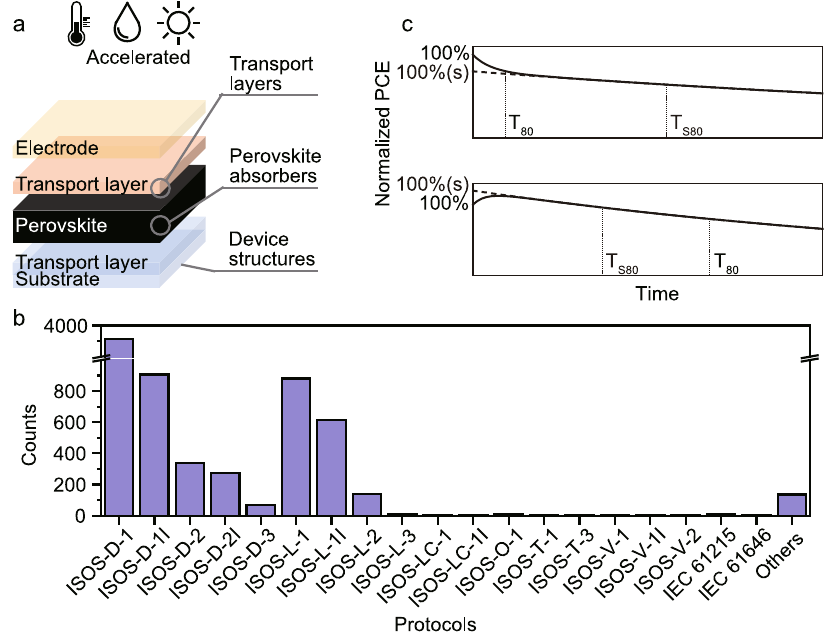
Fig. 1 | Diagrams of perovskite solar cell stability tests. a General device archi- tecture of a perovskite solar cell. b The distribution of stability protocols used for stability data in the Perovskite Database. c Two possible ef fi ciency decay curves of perovskite solarcells illustrating different types ofburn-inbehaviorsfollowedbya